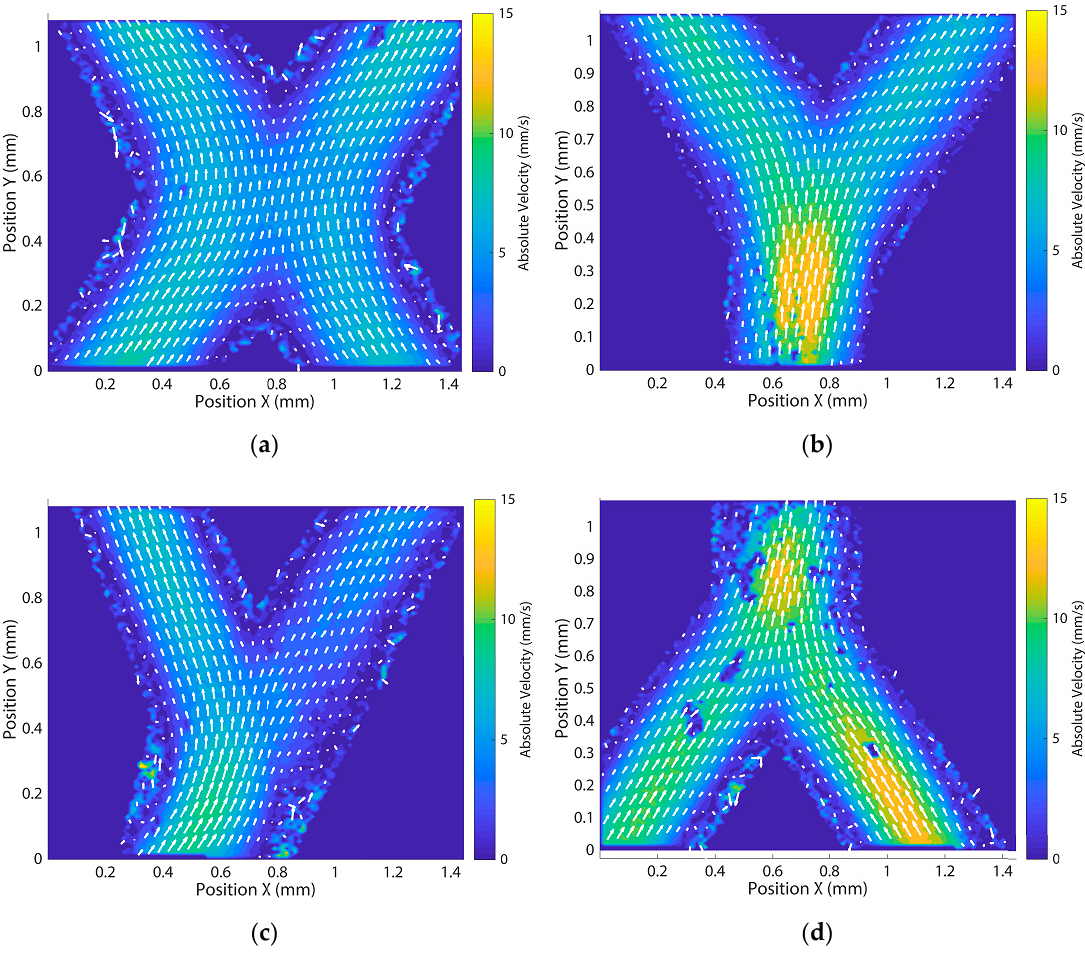
Figure 5. PIV measurement results for di ff erent crossings and bifurcations of the channel networks. Flow is from bottom to top of the images. Vectors indicate flow direction and absolute velocity. Absolute velocity is also represented in the colour coding of the flow field. ( a ) Flow direction and absolute velocity for the crossing junction inside the dashed area of the crossing network of Figure 4b; ( b ) Flow direction and absolute velocity for the bifurcating junction of the crossing network at the inlet (dashed area Figure 4b); ( c ) Flow direction and absolute velocity for the 2nd bifurcating junction of the second order bifurcating network in the dashed area of Figure 4d; ( d ) Flow direction and absolute velocity for the final merging junction of the second order bifurcating network inside the dashed area in Figure